Question: Draft a figure caption describing what is shown.
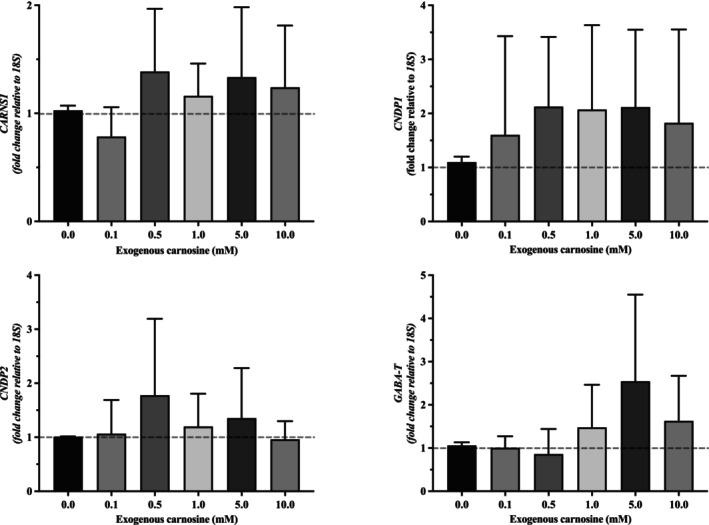
Answer: Gene expression of enzymes involved in carnosine synthesis ( CARNS1 ) and hydrolysis ( CNDP1 and CNDP2 ) and β‐alanine transamination ( GABA‐T ) in differentiated H9c2 cardiomyocyte cells after 4 h of exogenous carnosine incubation. Data are presented as fold change, normalized to the reference gene 18S , with statistical analyses conducted on delta Ct values. All concentrations have n = 6, except for 0.1 mM ( n = 4) and 0.5 mM ( n = 5). Data are presented as mean ± 1 SD.